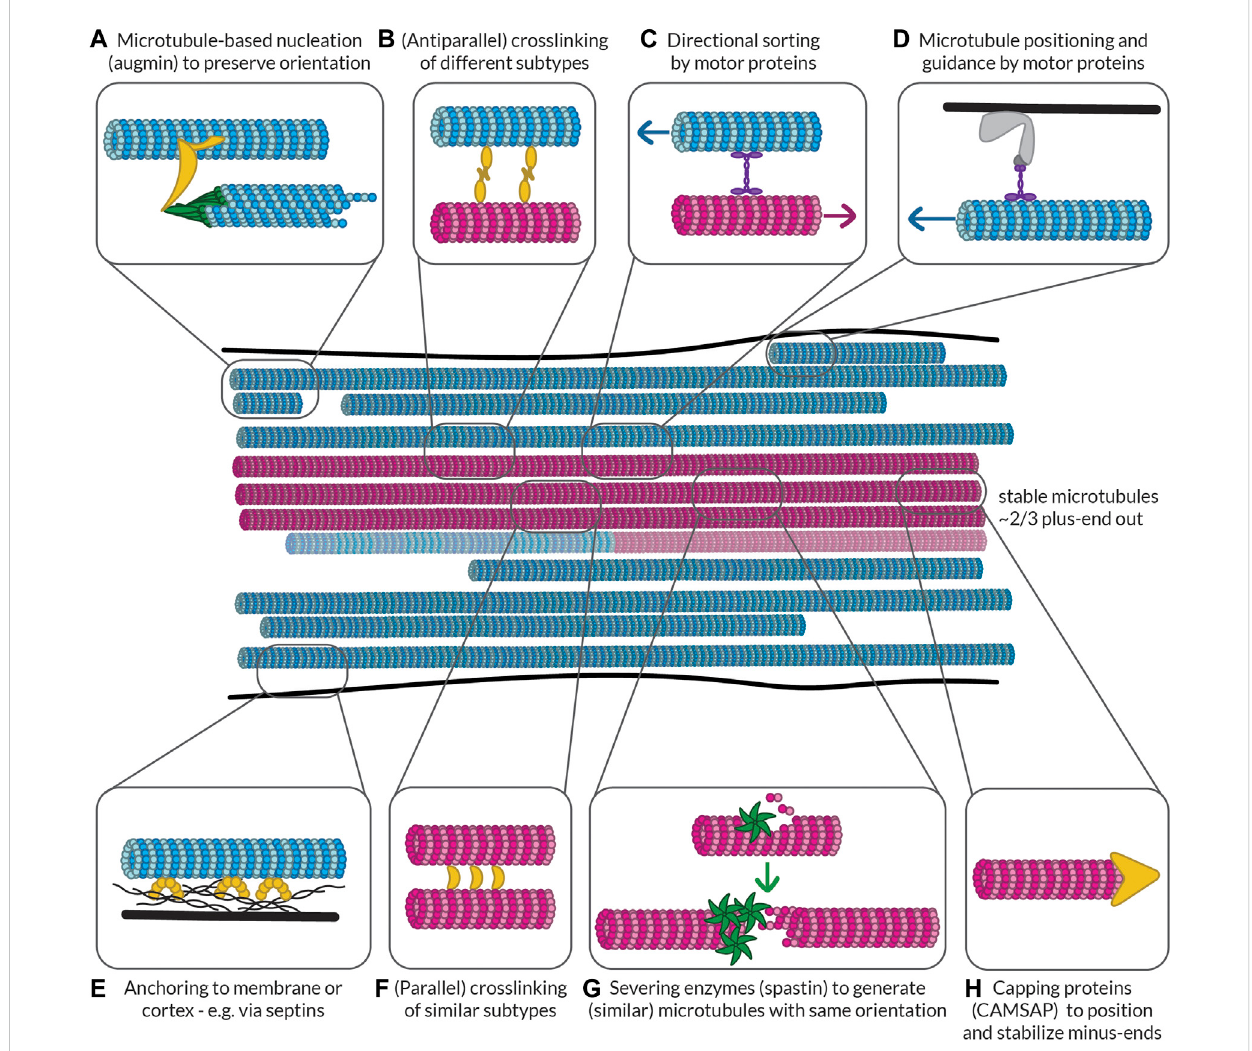
Possible ways to build and maintain (partially) segregated dendritic microtubule subsets. Some of the mechanisms that could be at play to help establish and maintain subset identity in terms of orientation, PTMs, and MAP decoration. Controlled nucleation, such as with (A) augmin and (G) off of microtubule seeds generated by spastin-mediated severing can help preserve local microtubule orientation. Different mechanisms can then help (F) bundle similar microtubules via (parallel) crosslinkers, (B) link different bundles via (antiparallel) crosslinkers, and (C) keep uniform orientation within bundlesbypushingoutmicrotubulesoftheoppositeorientation.Microtubulescanalsobeproperlypositionedbasedontheirorientation,PTMs,orMAPs via (D) motor proteins anchored to the membrane or cortex or (E) other MAPs such as septins anchored to the membrane or cortex. Finally, (H) capping proteins such as CAMSAPs can help to position the (minus-)ends of microtubules properly relative to, e.g., branch points or synapses. All these proteins could recognize the relative orientation of microtubules or the complement of MAPs and PTMs that they bear. Furthermore, by bundling similar microtubules, tubulin-modifying enzymes and MAPs could move between microtubules to help maintain subset identity. Magenta microtubules are stable (i.e., have an expanded lattice and are decorated with the associated MAPs such as MAP6 and PTMs such as acetylation and detyrosination), while blue microtubules are dynamic (i.e., have a compacted lattice and are decorated with MAPs such as EB and are tyrosinated). There is a possibility that some microtubules are mixed and have a stable base and a dynamic end, so such a microtubule is also